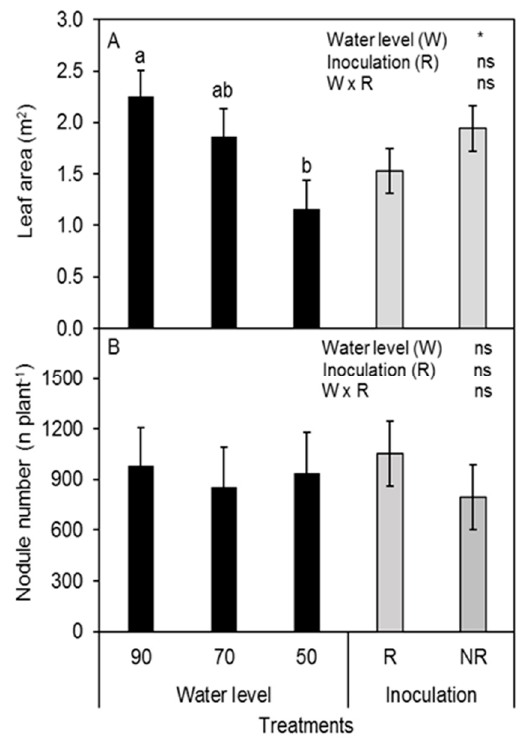
Figure 3. ( A ) Leaf area and ( B ) root nodule number of cowpea under different soil water regimes (90%, 70%, and 50% of SWHC) and rhizobia inoculation. Values are means + SE (n = 8 for 90%, 70%, and 50% of SWHC treatments and n = 12 for R and NR treatments). Different letters indicate significant differences in the experimental factor at p < 0.05 according to Duncan’s multiple range test.